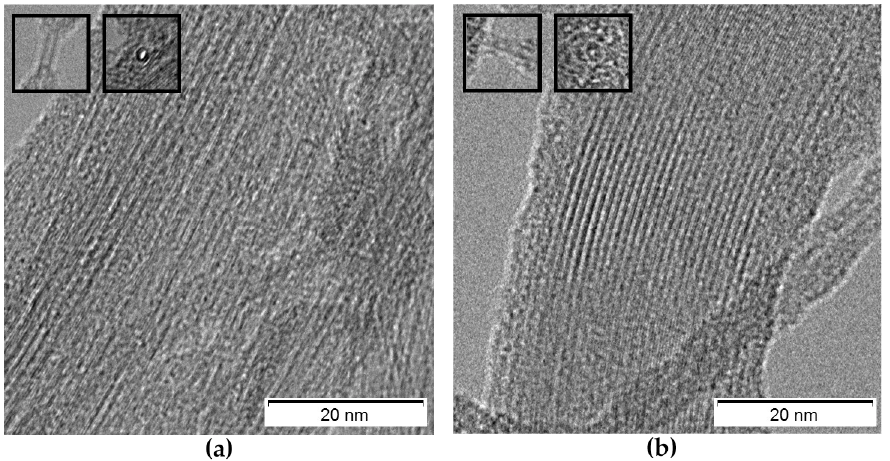
Figure 4. TEM images of ( a ) pristine (p-) and ( b ) oxidized (ox-) DWCNTs. Insets show details of individual DWCNTs crossing the focal plane, where d ~ 1.6 nm.